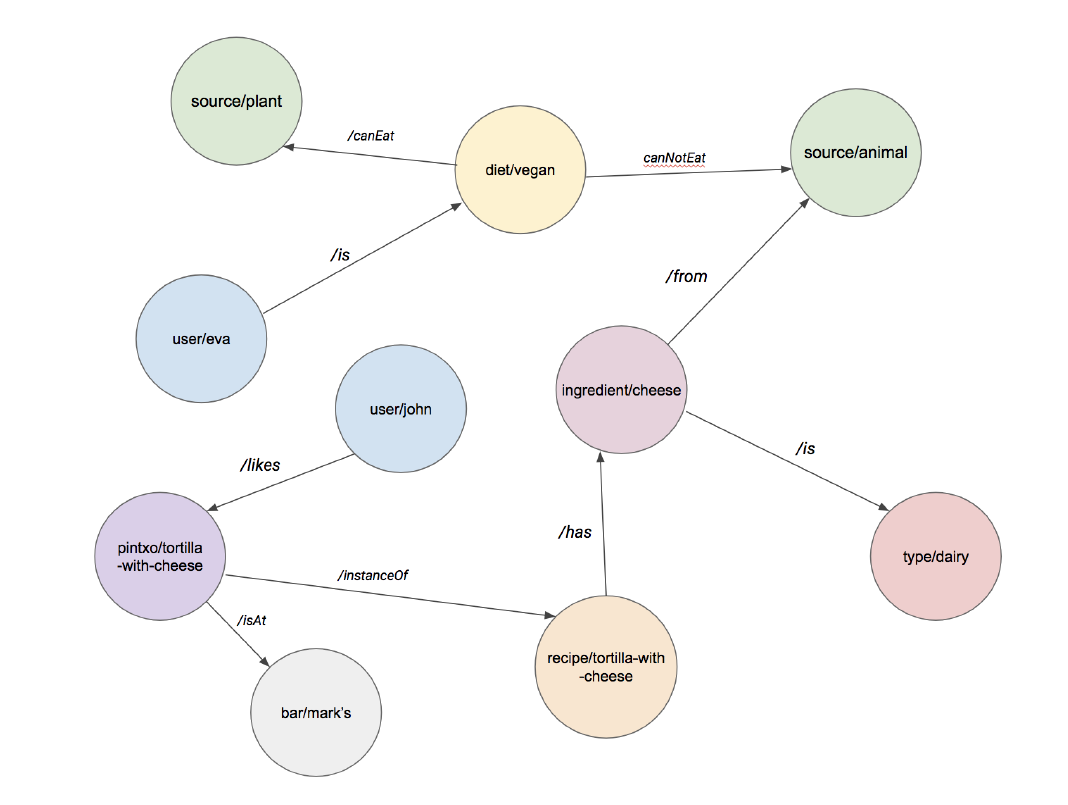
Figure 5. Example data from Figure 2 (some properties do not appear) represented in semantic